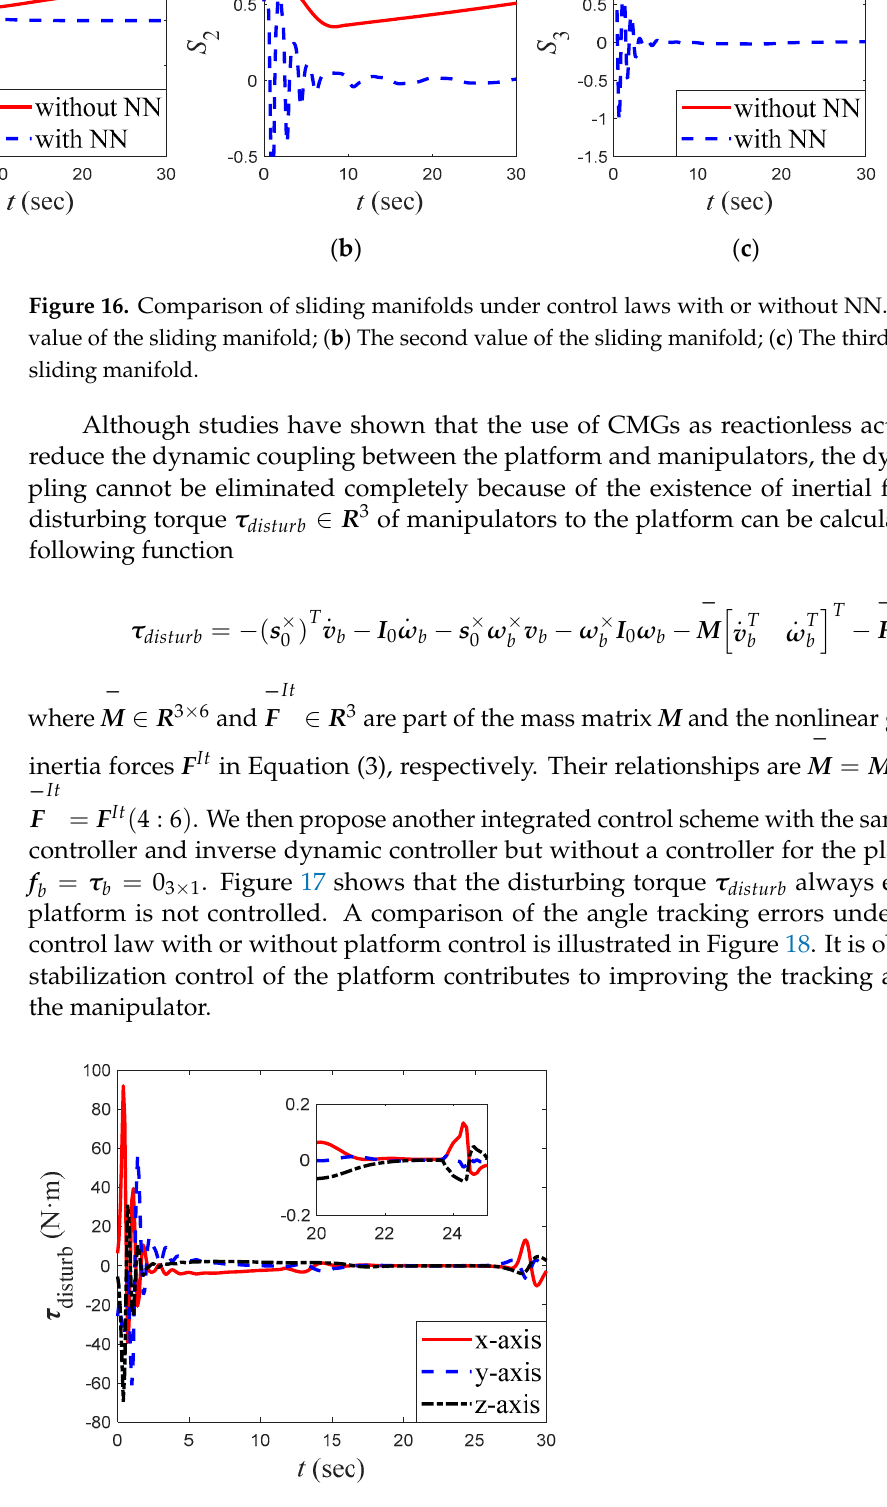
Figure 15. Comparison of angle tracking errors under control laws with or without NN. ( a ) The first value of the angle tracking errors; ( b ) The second value of the angle tracking errors; ( c ) The third value of the angle tracking errors.